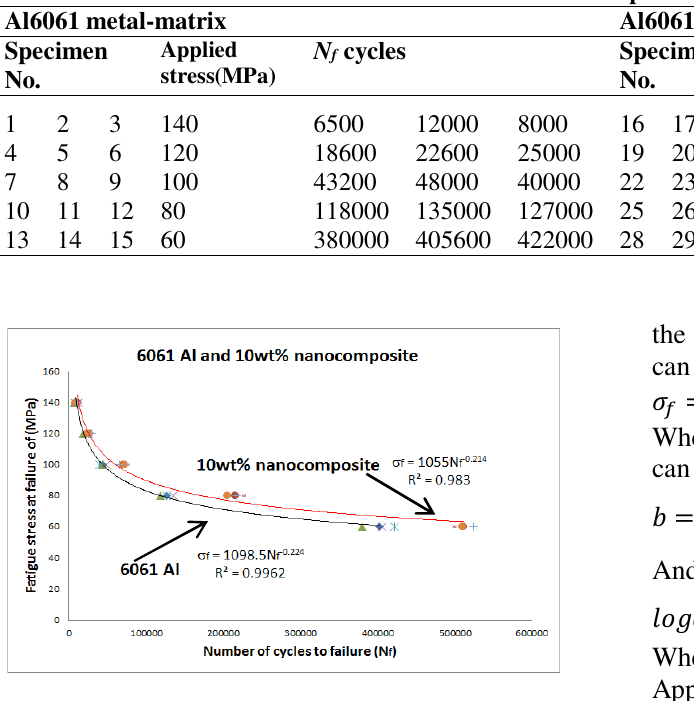
Fig. 3. S-N curves for both 6061 Al and 10wt% nanocomposite.